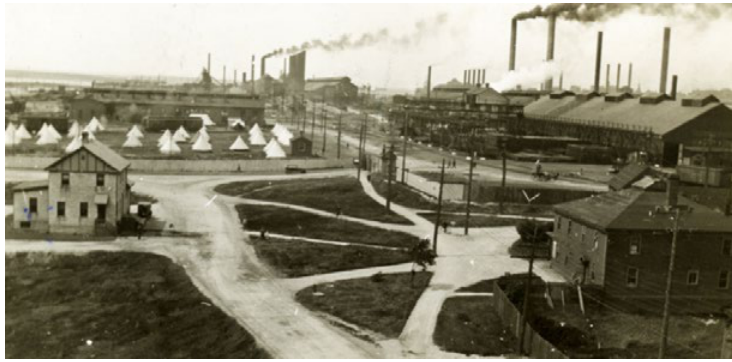
Figure 2. Soldiers at Steel Plant, 1923 (Source: Beaton